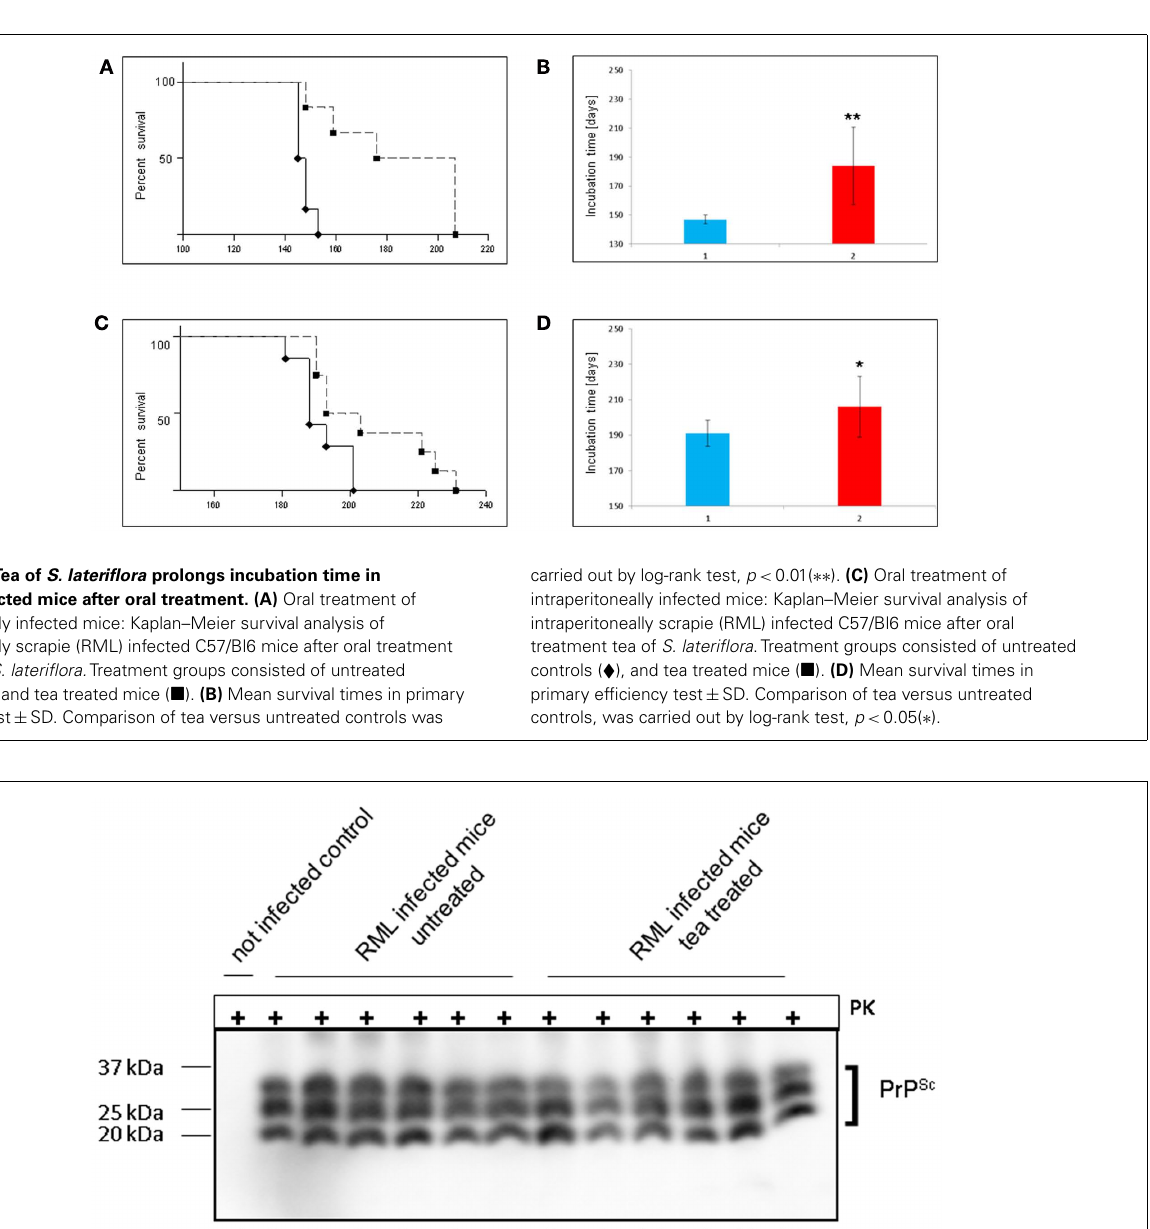
PrP Sc from RML infected mouse brains and lanes 8–13 PrP Sc from RML infected mouse brains that were treated with tea from S. lateriflora .Western blot was carried out with pab Ra10 and analyzed by chemiluminescence